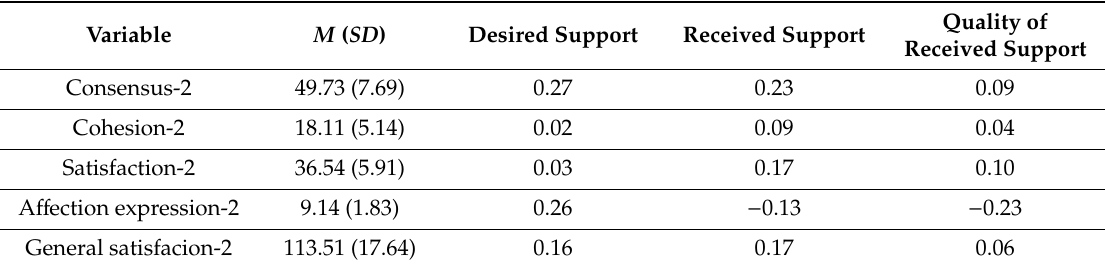
Table 4. Pearson’s linear correlation coe ffi cient for social support and a general relationship satisfaction and its components in the second stage of the